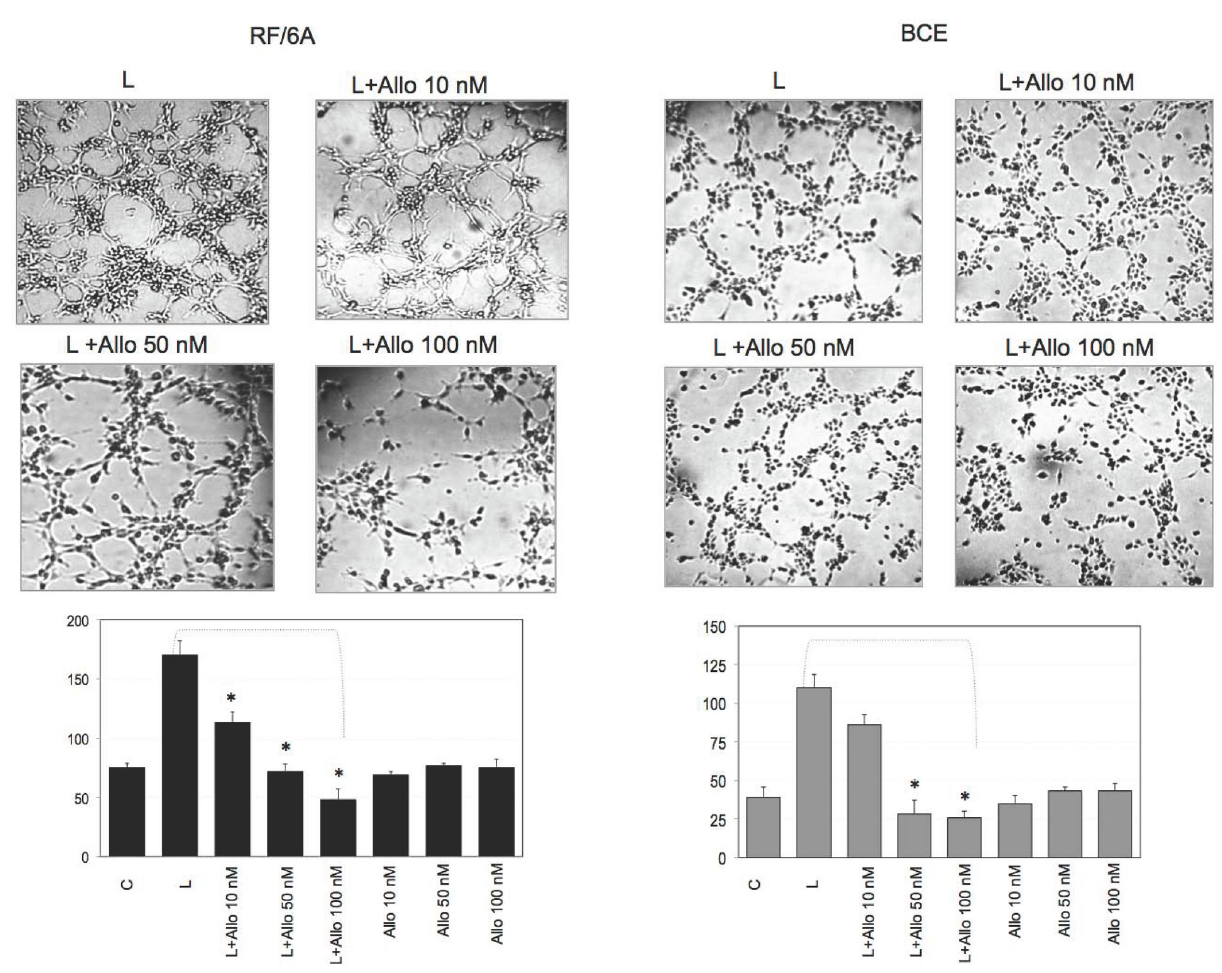
Figure 4. Effects of Allo-aca on leptin angiogenic activity in RF/6A and BCE cells. The assays were carried out as described in Materials and Methods. Untreated cells (C=SFM) and cells treated with 250 leptin (L) alone, L+ 1-100 nM Allo-aca (Allo), or 10-100 nM Allo-aca. The photographs represent ES formation under different treatments in RF/6A and BCE cells (central field of the well at 5x magnification is shown). The graph shows the number of ES (±SD) per visual field. Asterisks indicate significant (p≤0.05) differences vs.